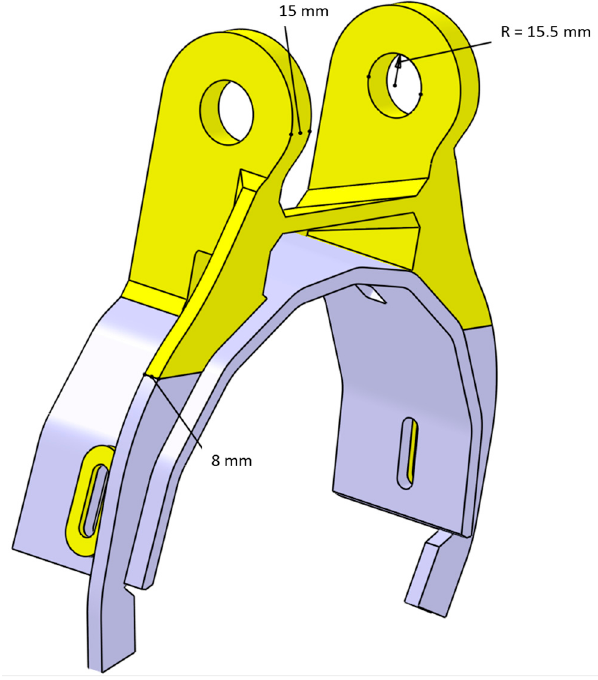
Figure 1. View of the demonstration part.